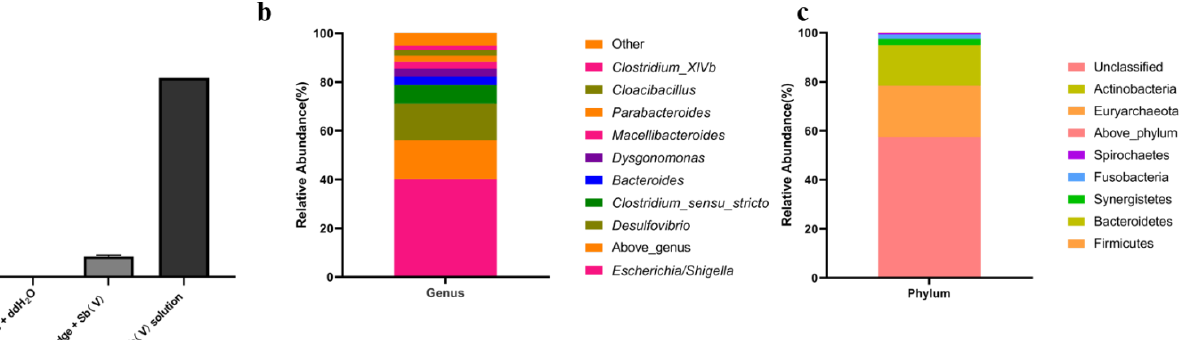
Figure 1. The removal of Sb in municipal sludge after 14-day incubation ( a ) and the community composition of SRB enriched community at the genus ( b ) and phylum levels ( c ).